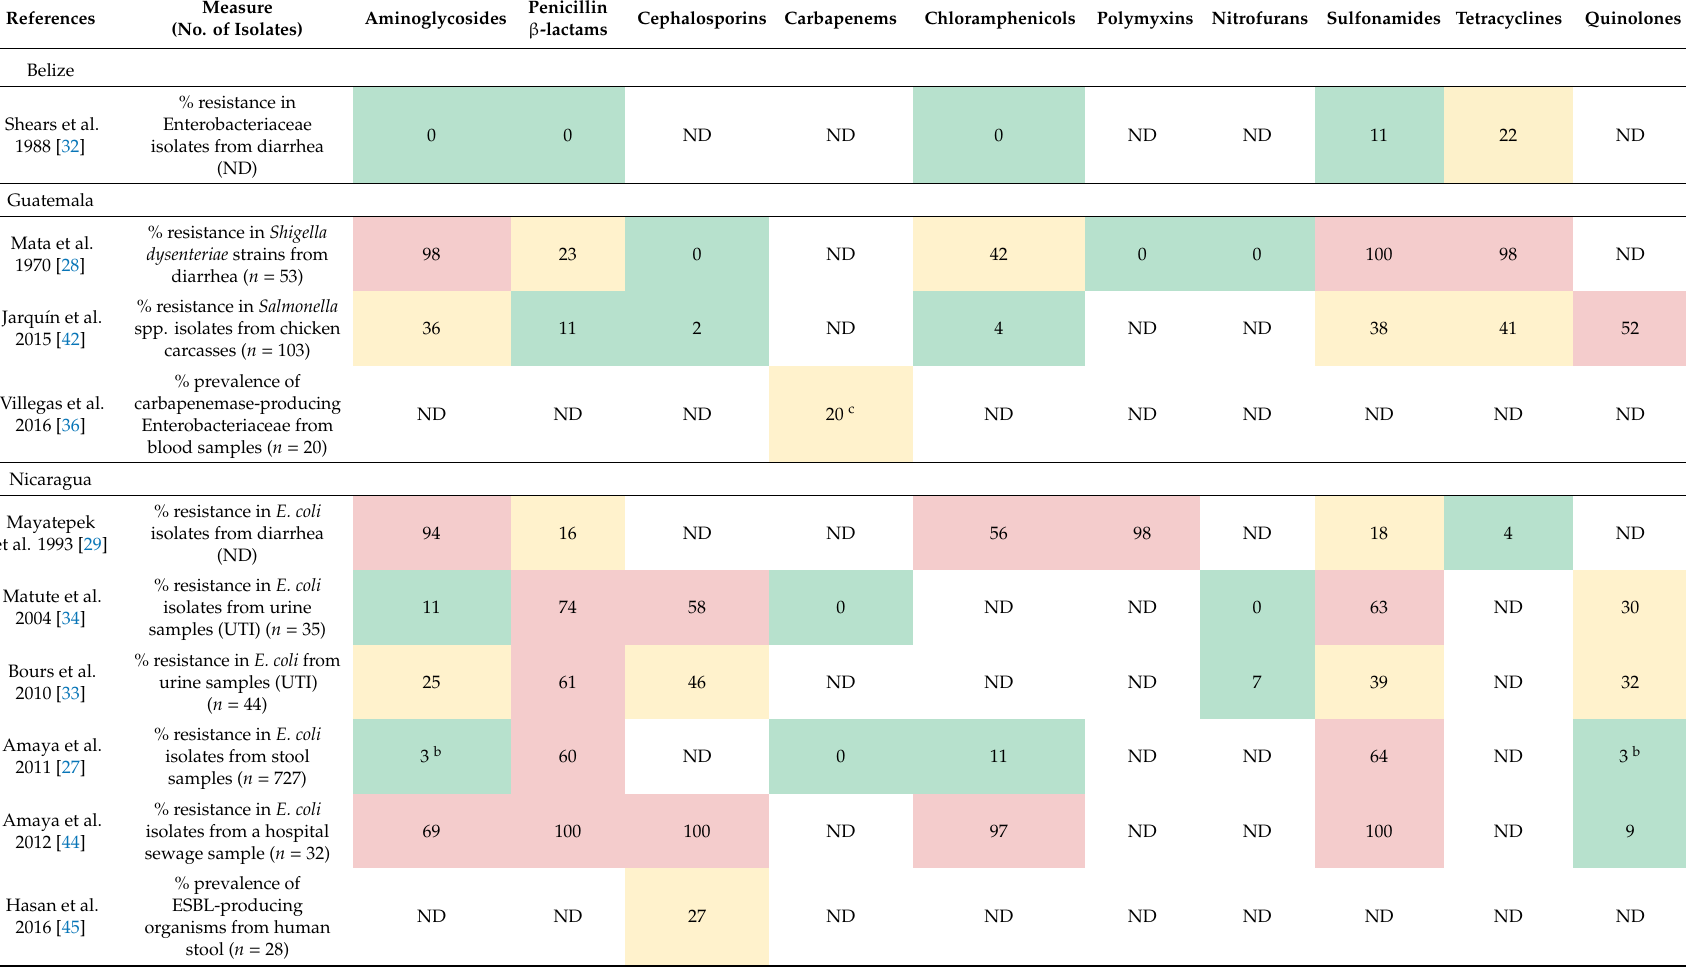
Table 1. Percent of isolates resistant by antibiotic class in the included studies on CA-ARE in Central